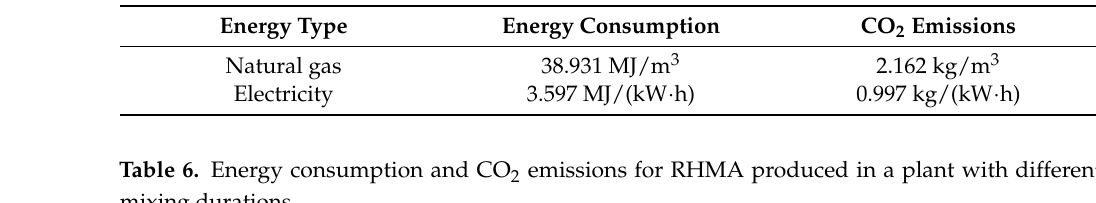
Table 5. Energy consumption and the CO 2 emissions for different types of energy.